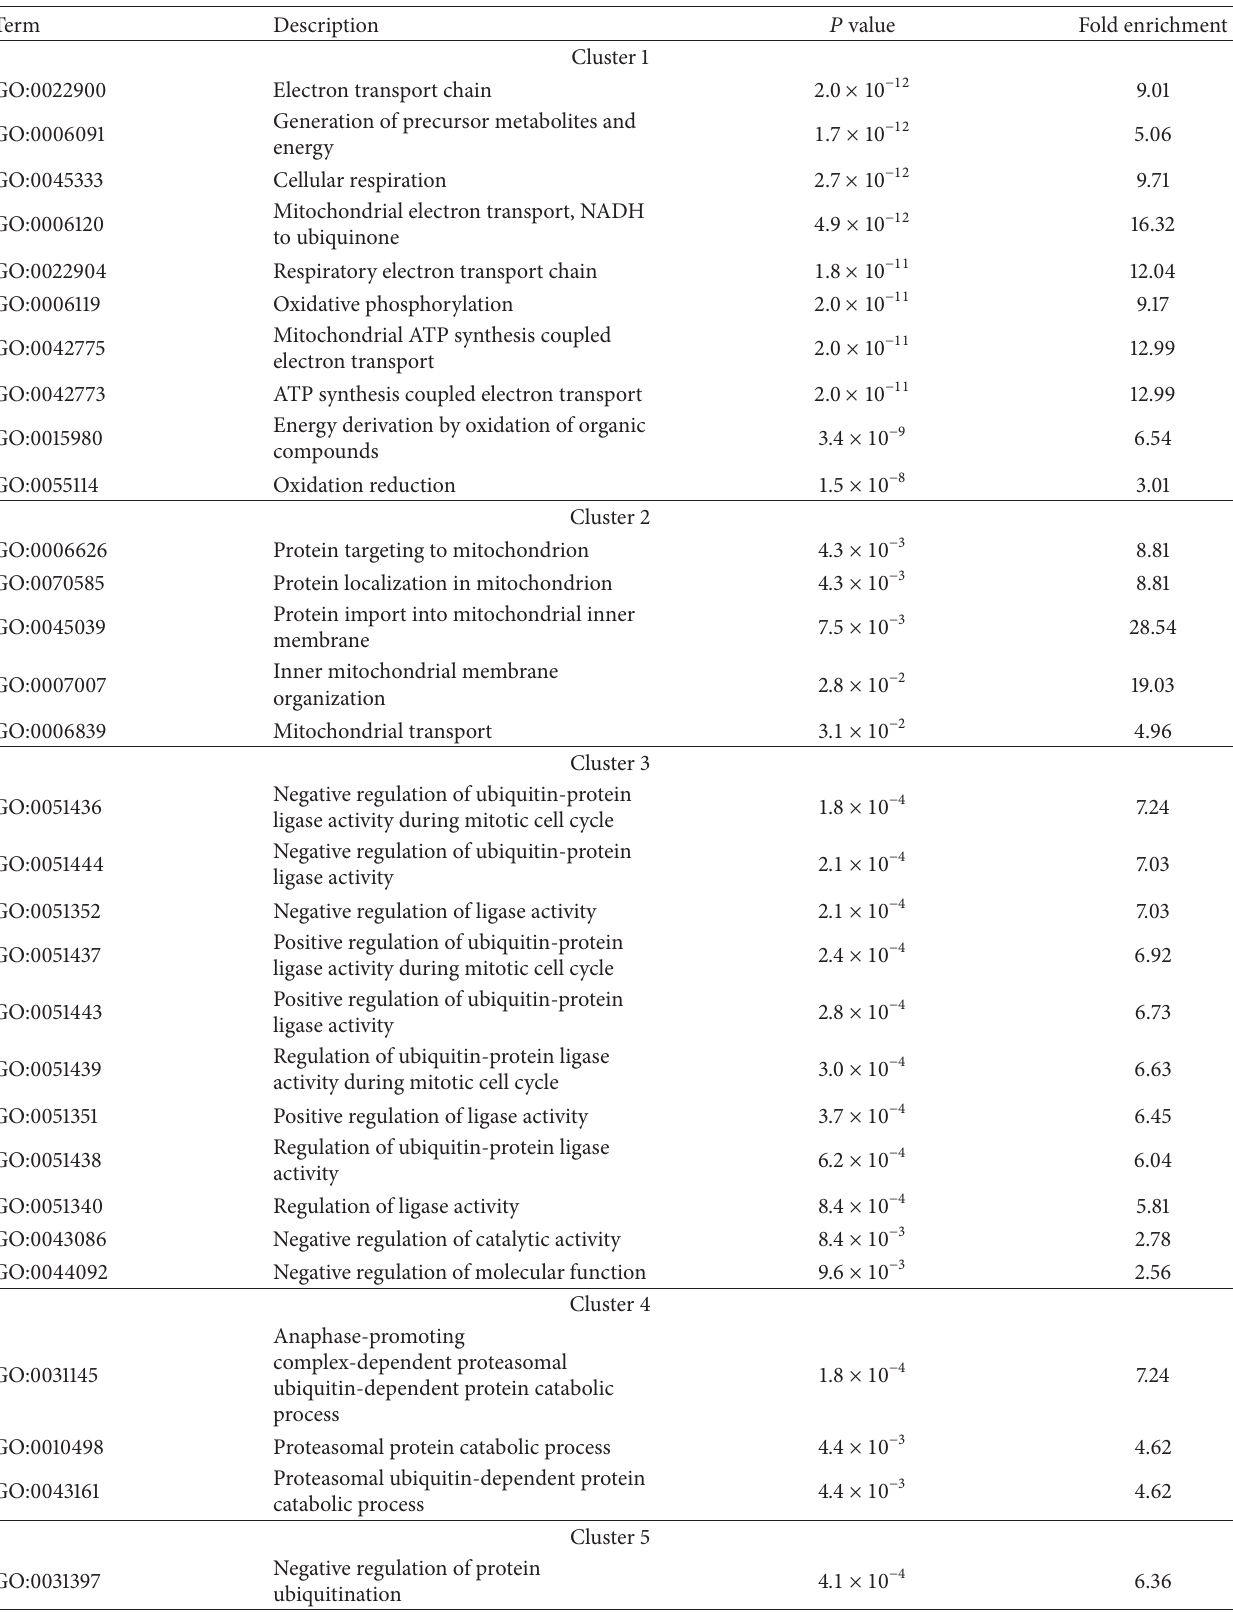
Table 4: GO analysis of genes reported to be deregulated in PBMC of RTT